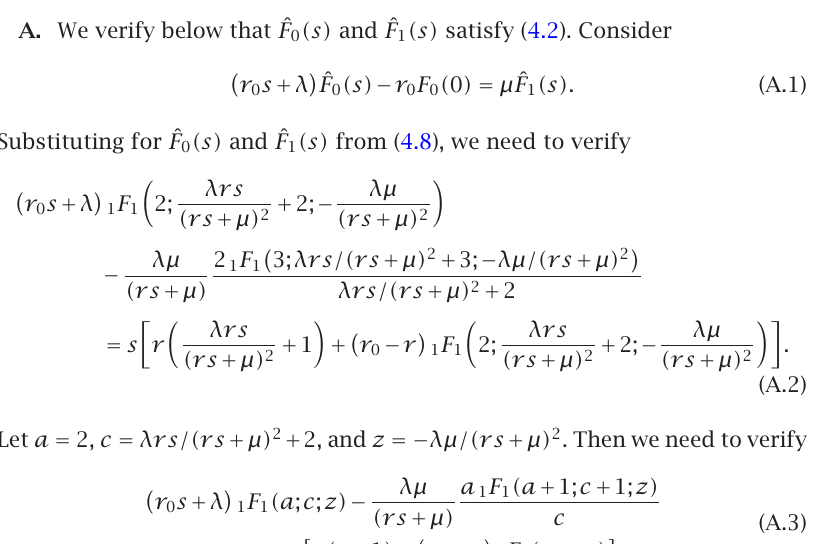
= − 1, r = 1, and N = 30. 0